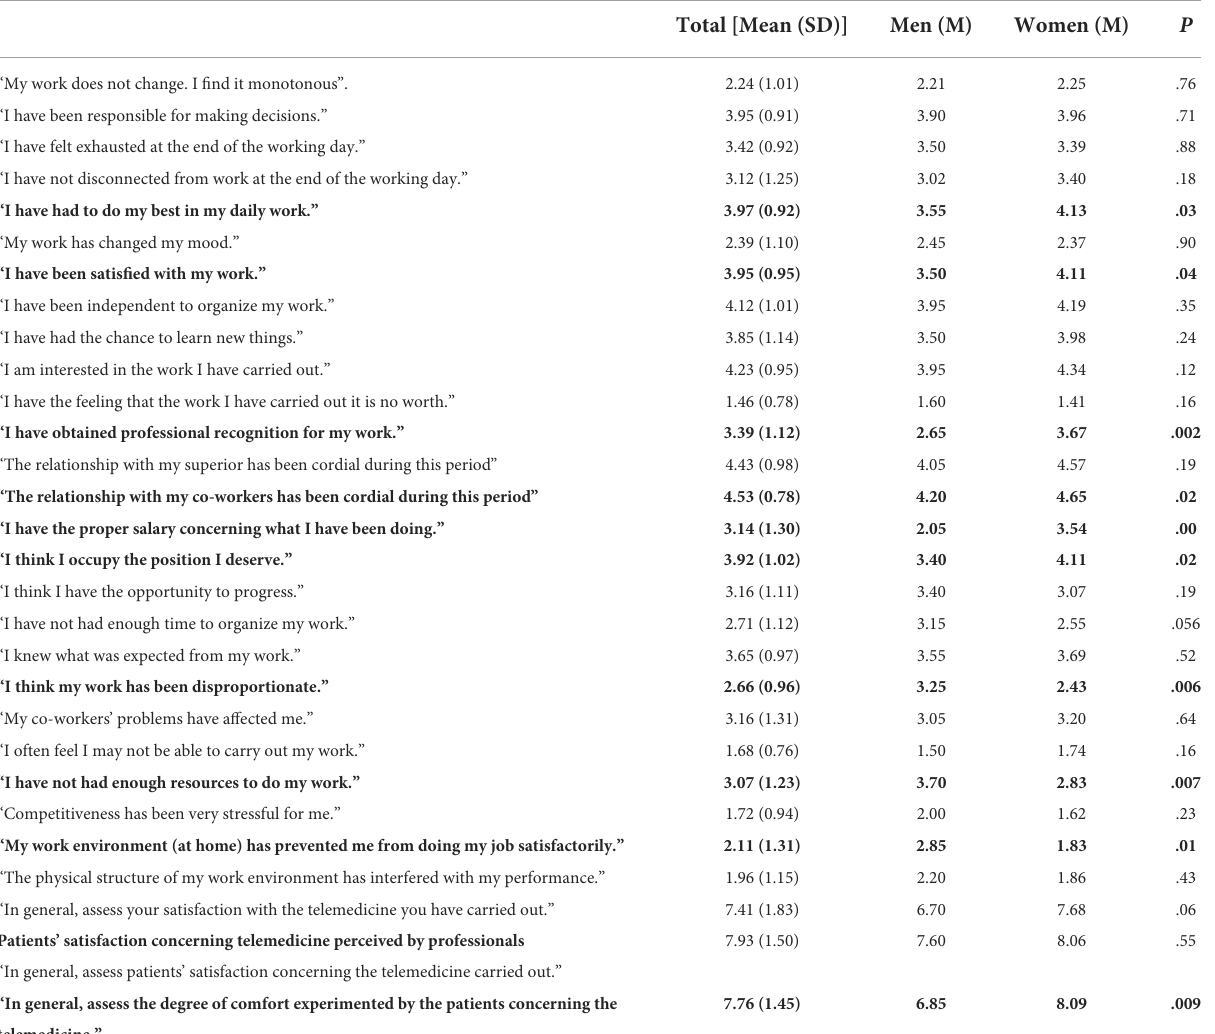
TABLE 3 The satisfaction of the professionals performing telemedicine and differences according to gender. Work satisfaction questionnaire of font roja